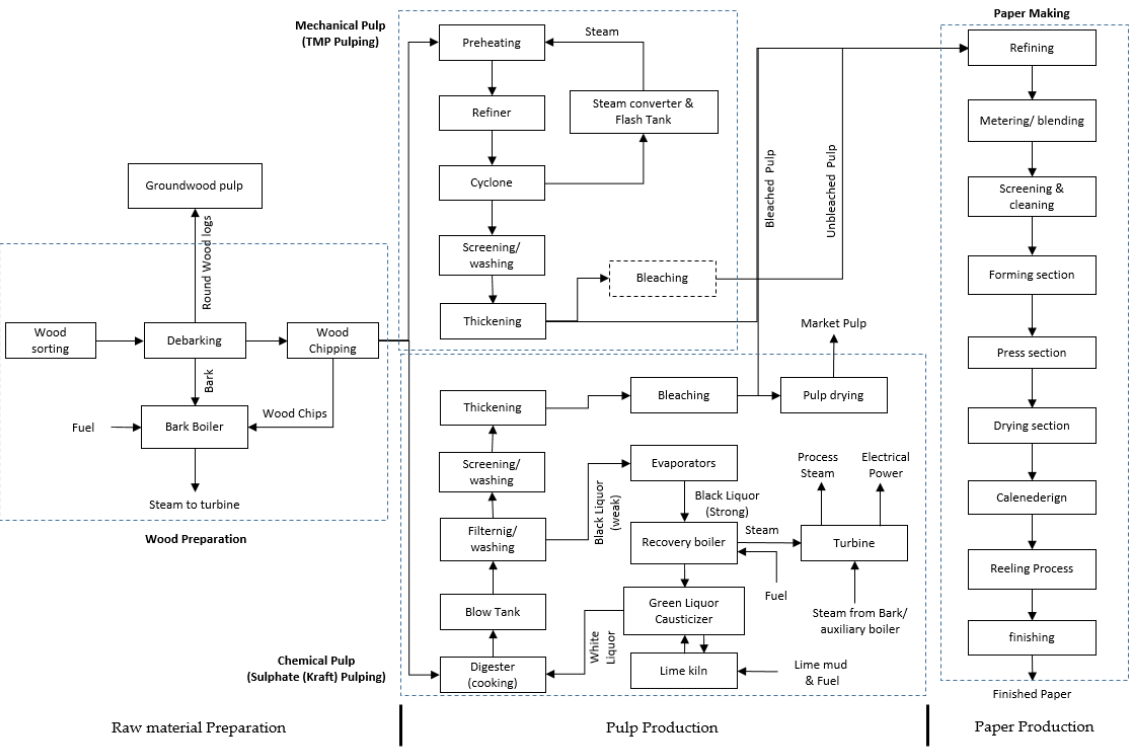
Figure 1. Overview of wood preparation, mechanical/chemical pulping, and papermaking processes design based on Joint Research Centre (JRC) [17] and ICF [16] reports.